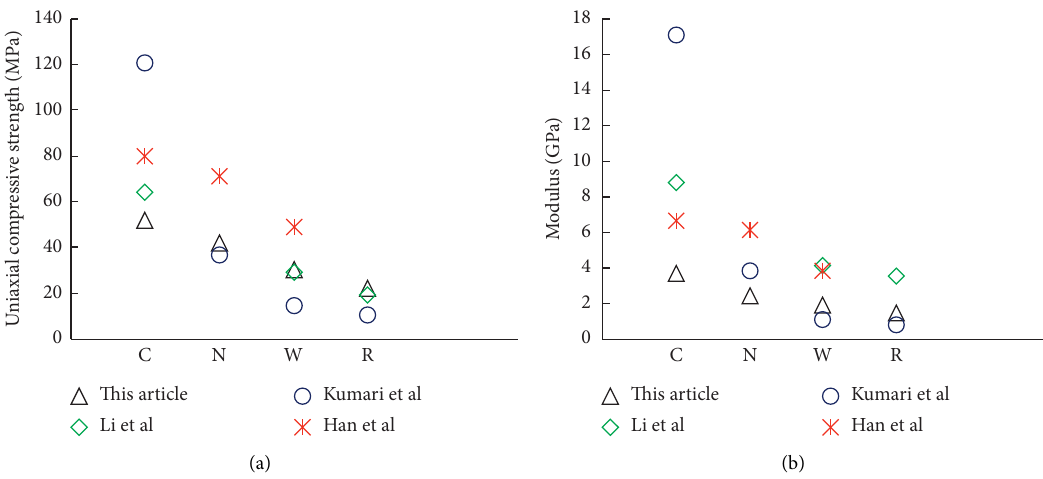
Figure 3: Ratio between strength and Young’s modulus [19, 28, 29].